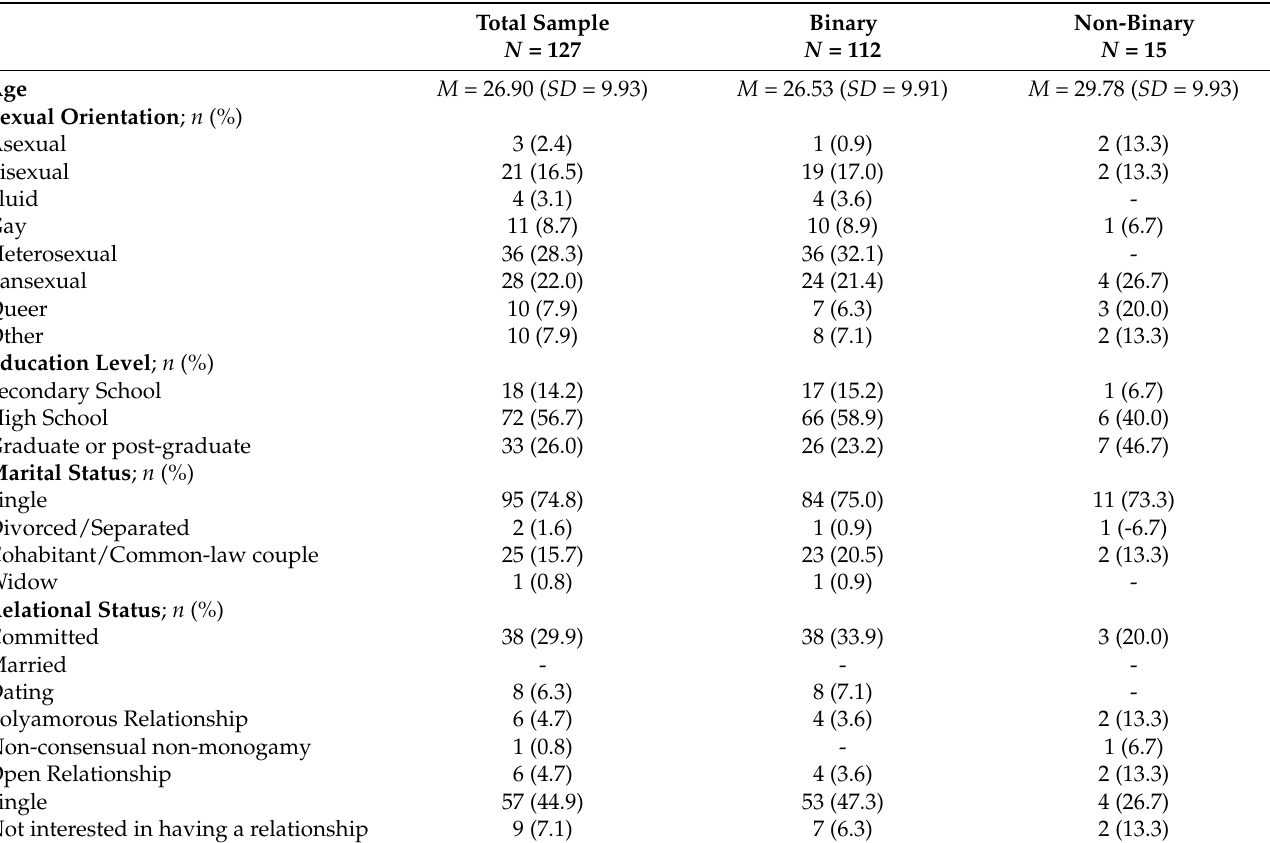
Table 2. Sociodemographic characteristic of the total sample and the sample split by binary and nonbinary